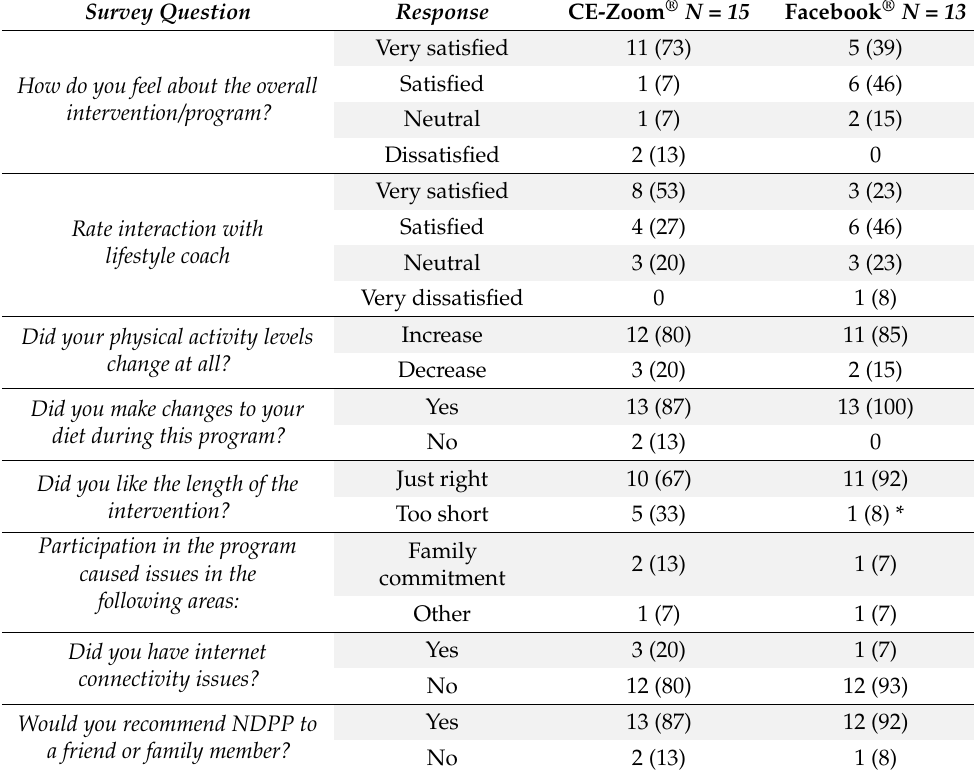
Table 4. Participant response to end study satisfaction survey by intervention